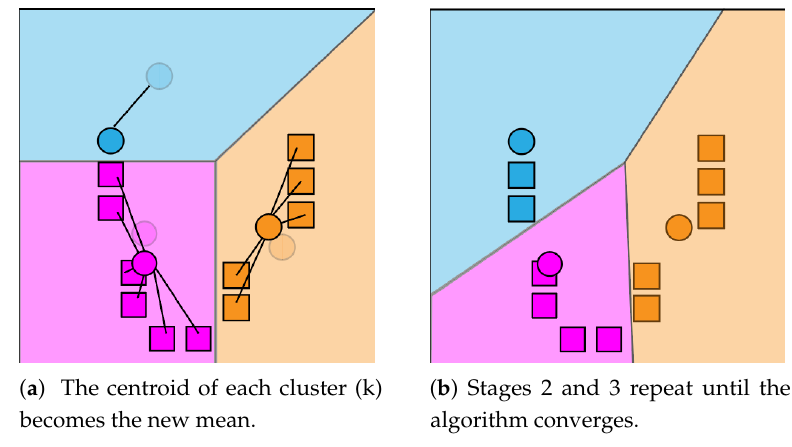
Figure 3. K-Means update step ( a ) and loop ( b